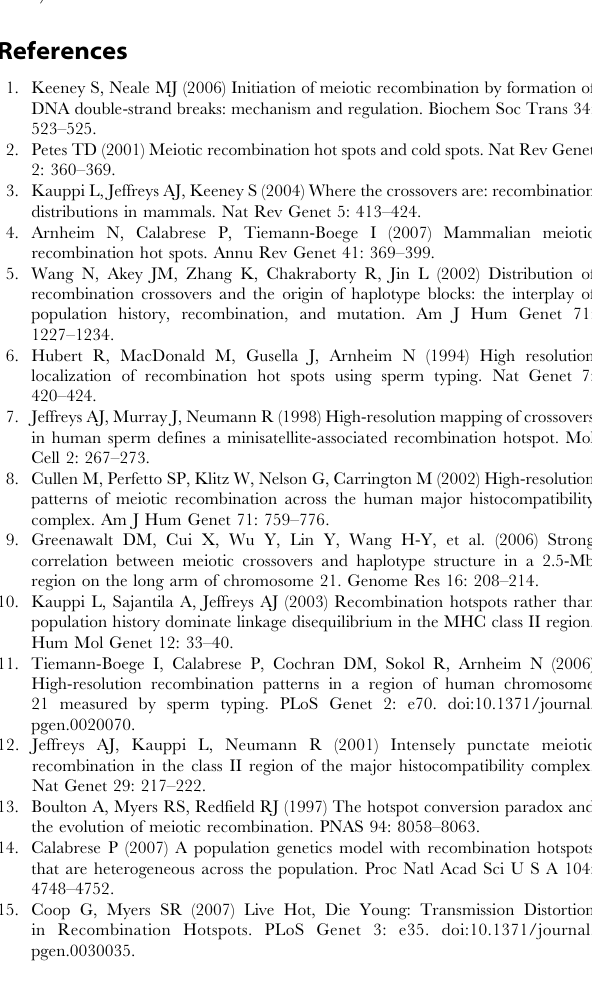
Figure S16 CHB-A hotspots overlap more crossovers not predicted by CEU-A hotspots compared to hotspots identified from an identically sized CEU-B sample. We randomly divided 60 individuals from the CEU sample in two sub-samples, CEU-A and CEU-B containing 30 individuals each and an identically sized tion rate maps and identified hotspots on chromosome 6 for each and 90% CI) not predicted by CEU-A hotspots that overlap hotspots found in CEU-B or CHB-A. (B,C) Histograms of the numbers of chromosome 6 crossover intervals not overlapping mapped to chromosome 6 (N= 189). Figure S17 The average MAF is not lower in the not-predicted crossover regions compared to that in the predicted crossover regions. We calculated and plotted mean value of minor allele frequency in four population samples for all SNPs located inside crossover intervals. Table S1 Positions of crossovers mapped in CEPH pedigrees. All coordinates are given relative to NCBI35 and NCBI36 versions of human genome assembly.